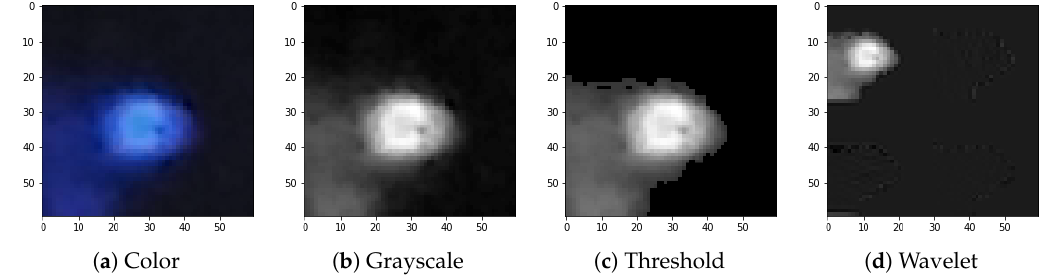
Figure 7. Preprocessing flow: ( a ) color input image, ( b ) grayscale accumulation, ( c ) adaptive thresholding, ( d ) wavelet transformation. Example of the artefact